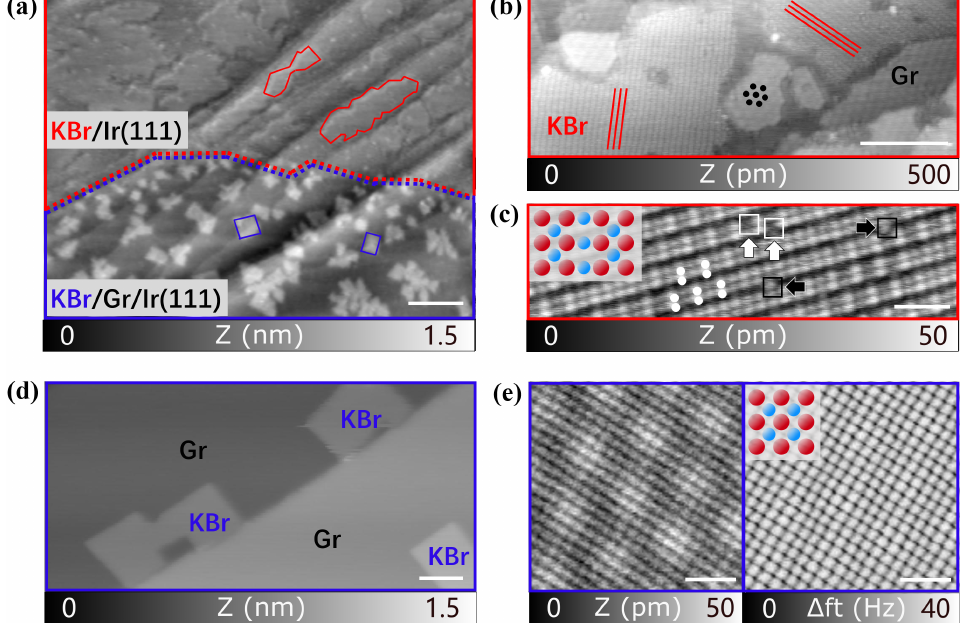
Figure 1. nc-AFM images of KBr accompanied with graphene on an Ir(111) surface: ( a ) Topography with both irregular KBr (top in red) and cubic KBr (bottom in blue). ( b ) Topography of KBr islands rotated in two directions (red lines) and graphene moiré (black spots) on Ir(111). ( c ) Atomic resolution of double parallel lines of reconstructed KBr on Ir(111), with lattice vacancies and adatoms marked with white and black squares, as well as pairs of protrusions marked with white spots, respectively, (the inset shows the atomic configurations with Br in red and K in blue). ( d ) Topography of cubic KBr on Gr/Ir(111). ( e ) Atomic resolution of cubic KBr on graphene on Ir(111), with the left topography image showing the graphene moiré and the right corresponding to the torsional frequency shift illustrating the cubic KBr lattice taken simultaneously at the same region. Scale bars for ( a ): 100nm, ( b , d ): 20nm and ( c , e ):